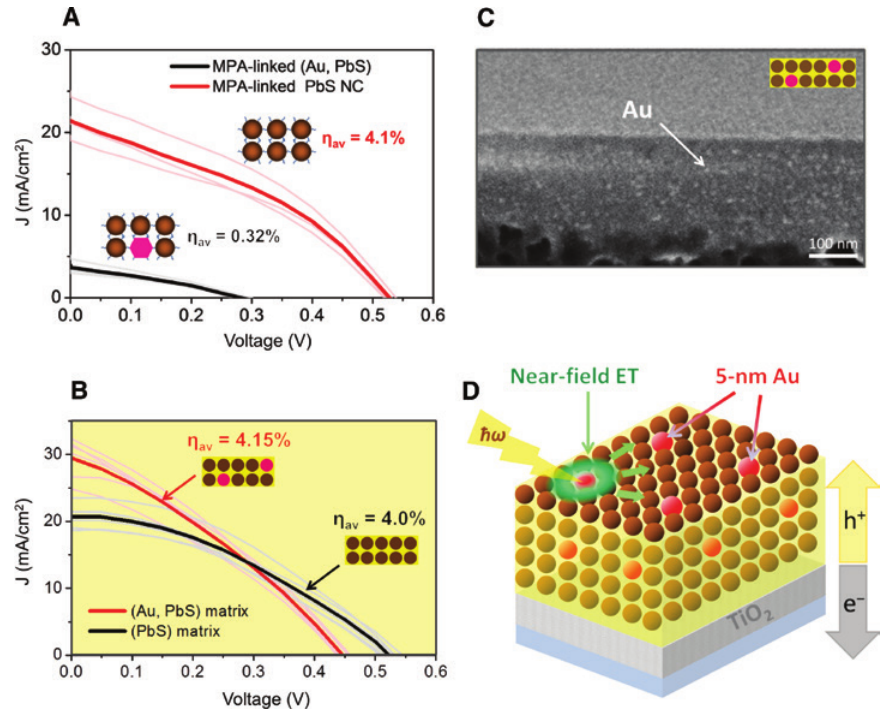
Figure 5: Current-voltage characteristics of plasmonic (Au, PbS) and control (PbS-only) QD solar cells featuring organic interlinking (A) and matrix encapsulation (B) of Au and PbS NP